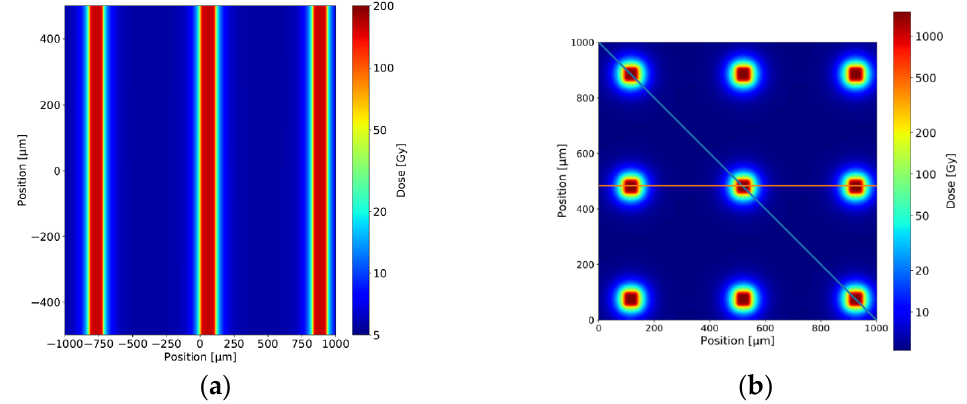
Figure 1. Scaled schematic of the dose distribution in a given target region seen in an upstream-to- downstream direction, shown for the monoplanar MBI with 50 µm wide microbeams ( a ) and PBI generated with the same multislit collimator used for the monoplanar MBI and additional horizon- tal fractionation, resulting in a grid of 50 µm × 50 µm pencilbeams ( b ). The centre-to-centre distance is 400 µm for both MBI and PBI.